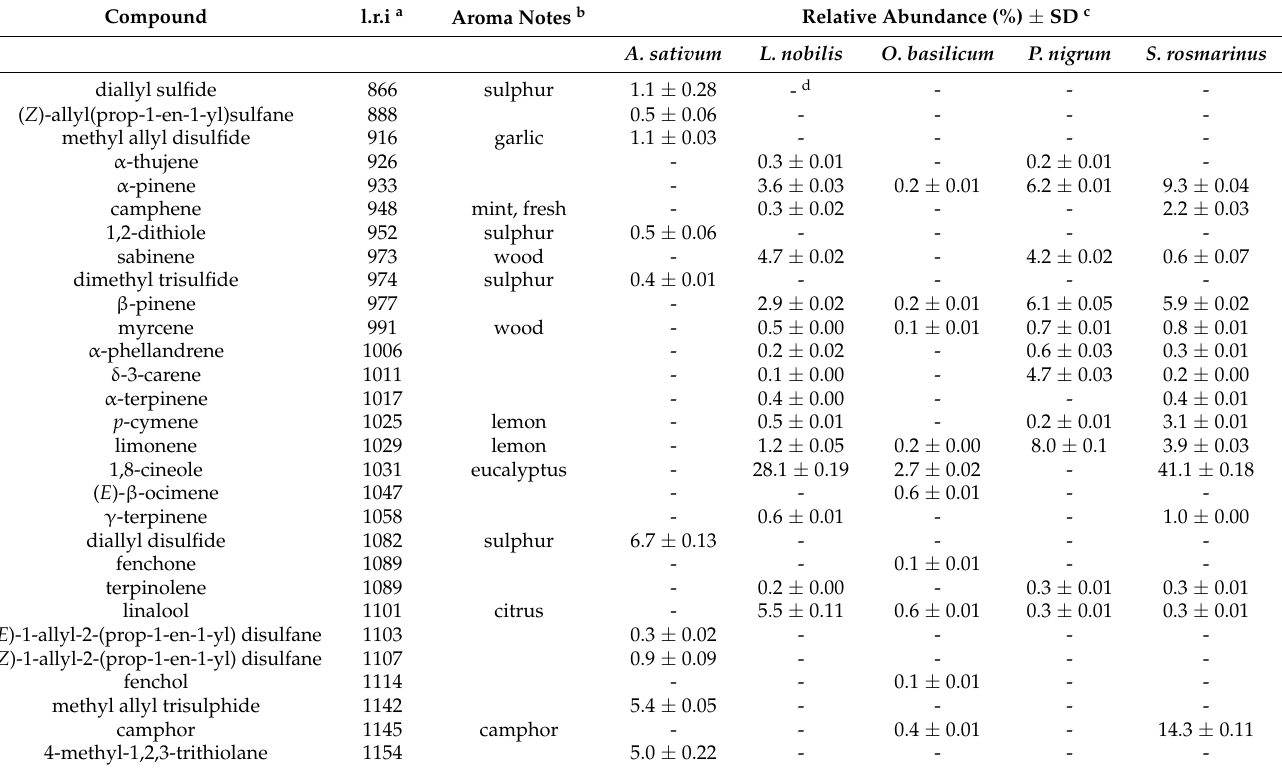
Table 1. Chemical compositions of the Allium sativum , Laurus nobilis , Ocimum basilicum , Piper nigrum , and Salvia rosmarinus essential oils